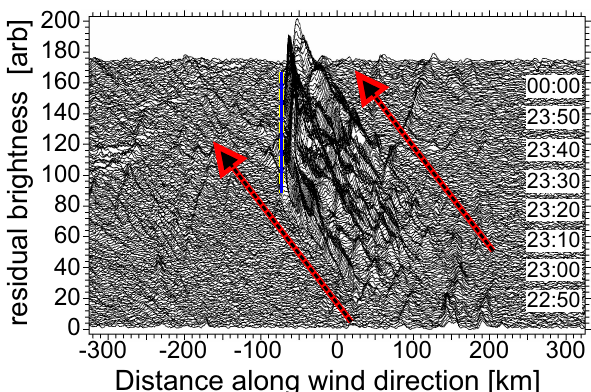
Fig. 16. Residual brightness along the direction of wind vector for different times between 22:40UT and 01:00UT. The brightness is increased by 1 for successive measurements. Positive distances are north-east of the origin. The brightness is smoothed by a 1.5km running mean. Red arrows mark Lagrangeian transport. An inten- sity feature of a passive tracer would move along the red arrows. The bottom of the rogue wave is marked by a yellow-blue